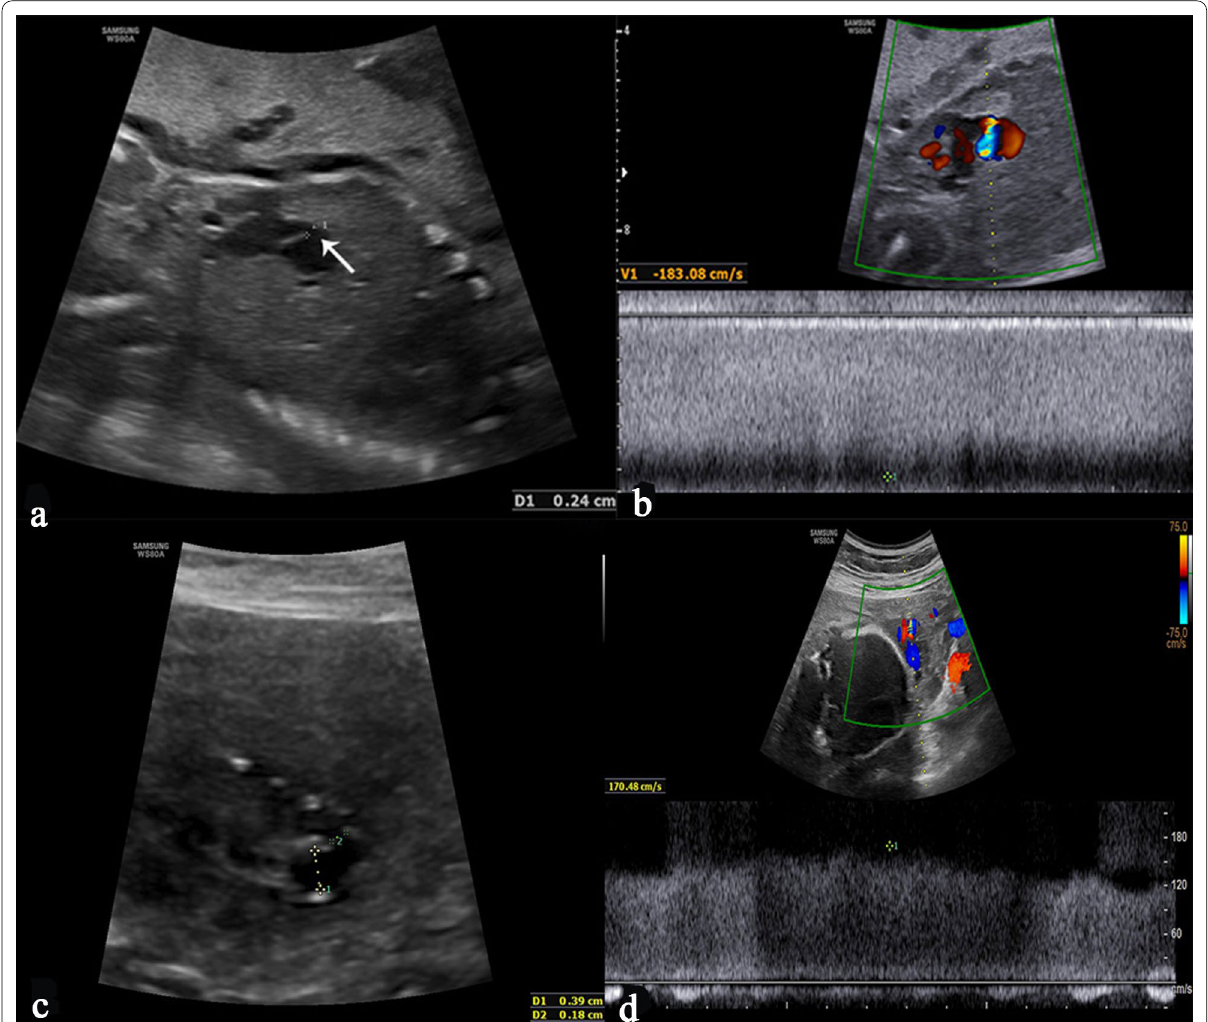
Fig. 11 Grayscale ultrasound image and pulsed Doppler image demonstrate the constriction of the umbilical vein. Images a and b illustrate the membranous constriction of the umbilical vein (arrow) in the intra-abdominal section. Images c and d show constrictive umbilical vein at a